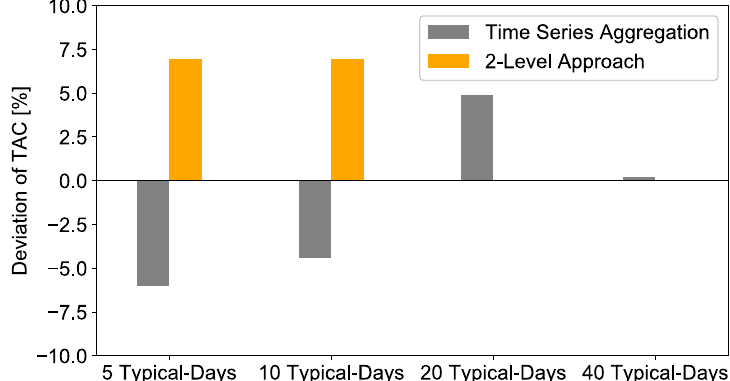
ff erent typical days compared to full time Figure 12. Deviation of total annual costs for different typical days compared to full time series. Figure 12. Deviation of total annual costs for di